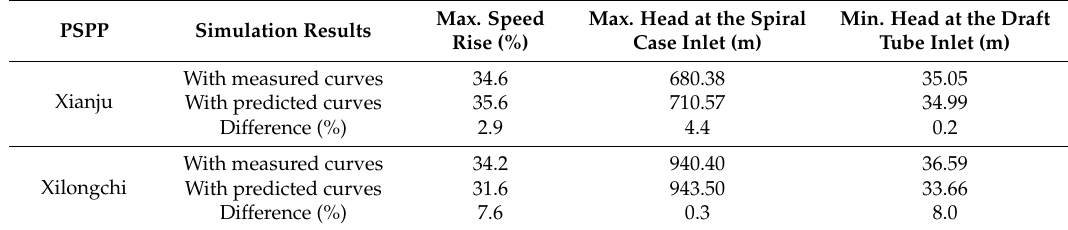
Table 6. Transient conditions during simultaneous load